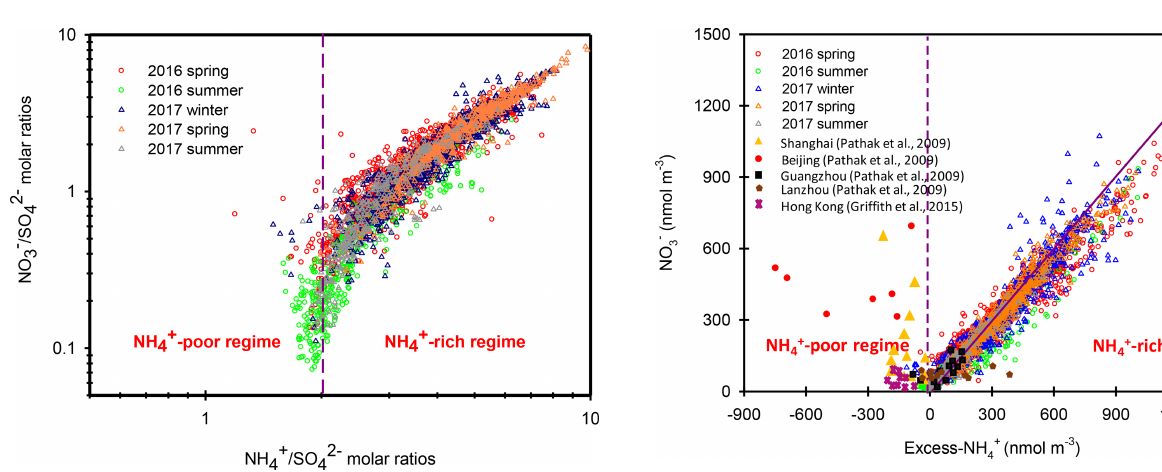
vs. excess-NH + molar concentra- 3 4